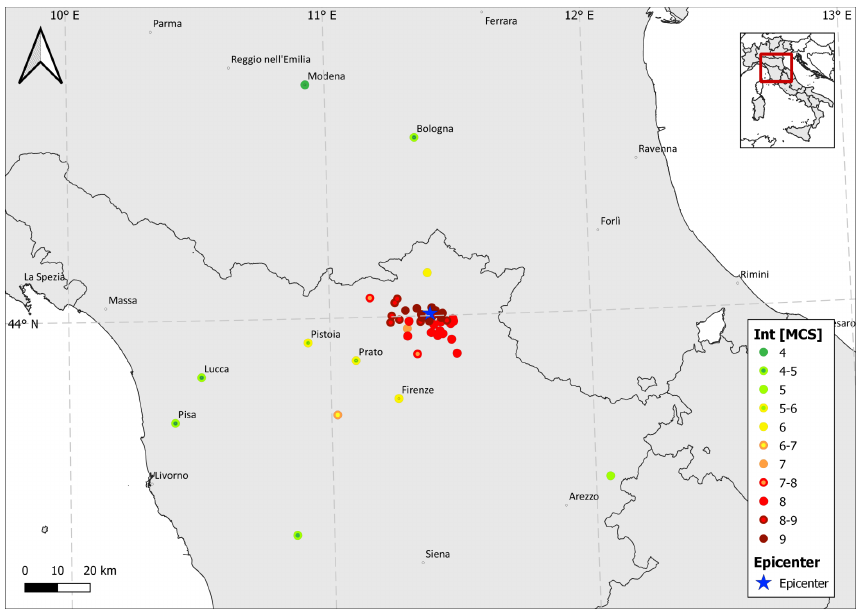
Figure 8. Intensity distribution of the 1542 Mugello earthquake assessed by Guidoboni et al. (2007) and reported in DBMI15.